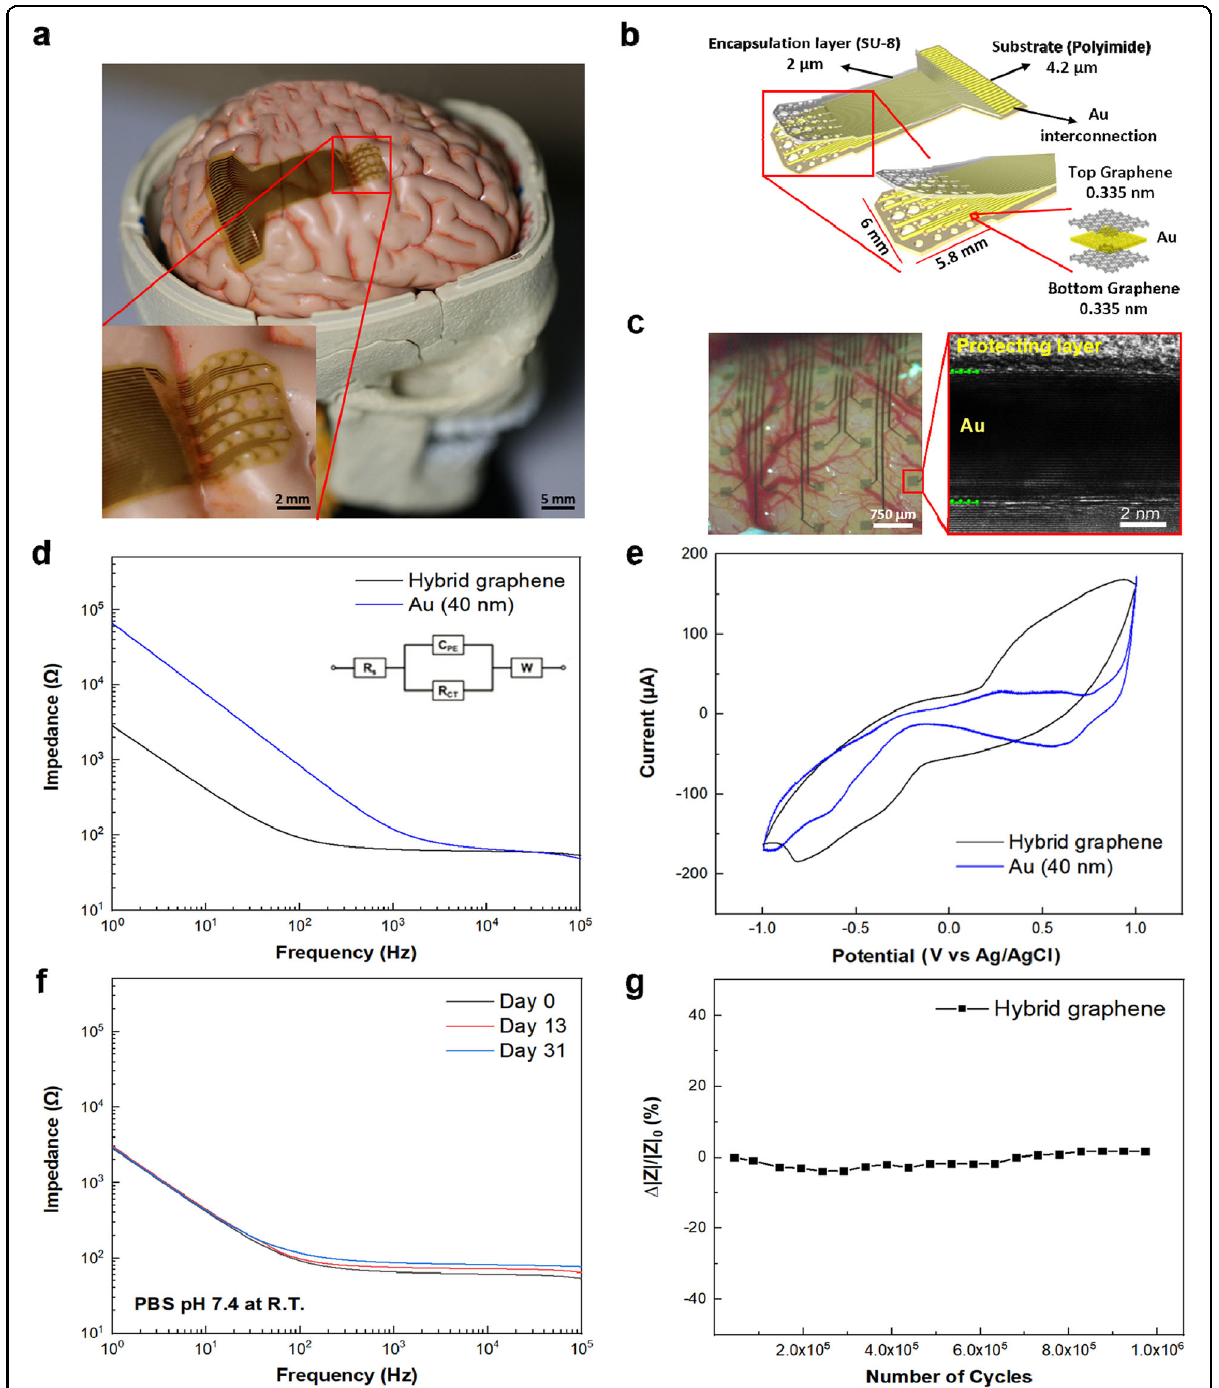
Fig. 1 Multichannel hybrid graphene electrode array to monitor brain activity and electrochemical characterization. a Photograph of the 32-channel hybrid graphene (Gr/Au/Gr) electrode array on an arti fi cial model of the cortex. b Schematic illustration of device fabrication. c Photograph of a device on the rat brain (left) and TEM image of the hybrid graphene-like thin fi lm used in the electrode array (right). d Electrochemical impedance spectroscopy (EIS) of the hybrid graphene electrode and Au (40 nm) electrode for a 1 × 1 cm 2 area in PBS and the equivalent circuit model fi tted with the EIS measurement results. The hybrid graphene electrode shows lower impedance. e Cyclic voltammetry results of both electrodes with a scan rate of 200 mV/s. f Long-term stability and g relative impedance with the cyclic electrical stimulation test of the hybrid graphene